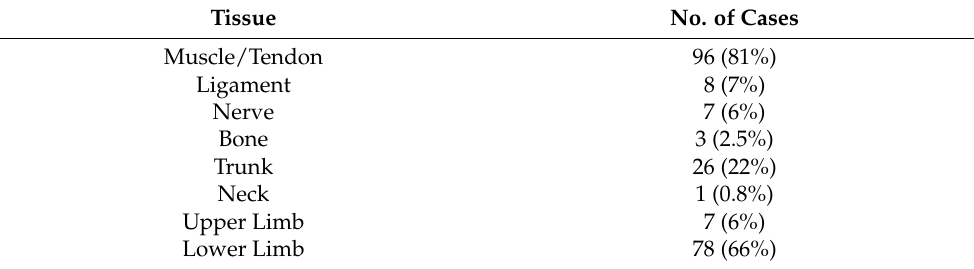
Table 2. Anatomical and tissue distribution of injuries.